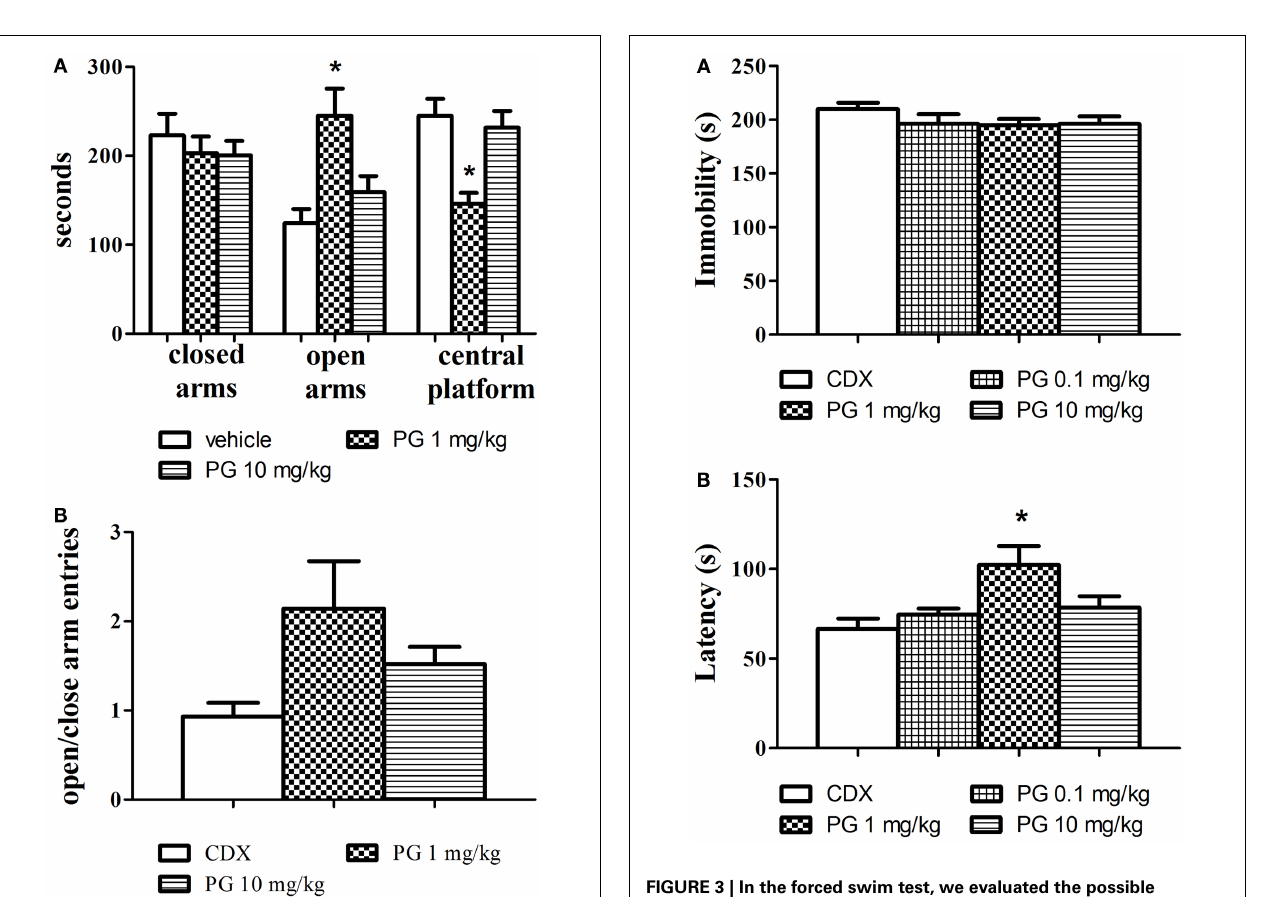
FIGURE 3 | In the forced swim test, we evaluated the possible antidepressant effect of PG . (A) Immobility time in the forced swim test was assessed 30min after i.p. administration of PG and vehicle. None of the doses applied significantly influenced floating. Average group values ± SEM. (B) In addition to immobility duration in the forced swimming test, we measured time to the first floating as well. Administration of PG at the dose of 1mg/kg significantly prolonged the latency to the first floating compared to controls. All values represent group means ± SEM. * p < 0.005 compared to the vehicle